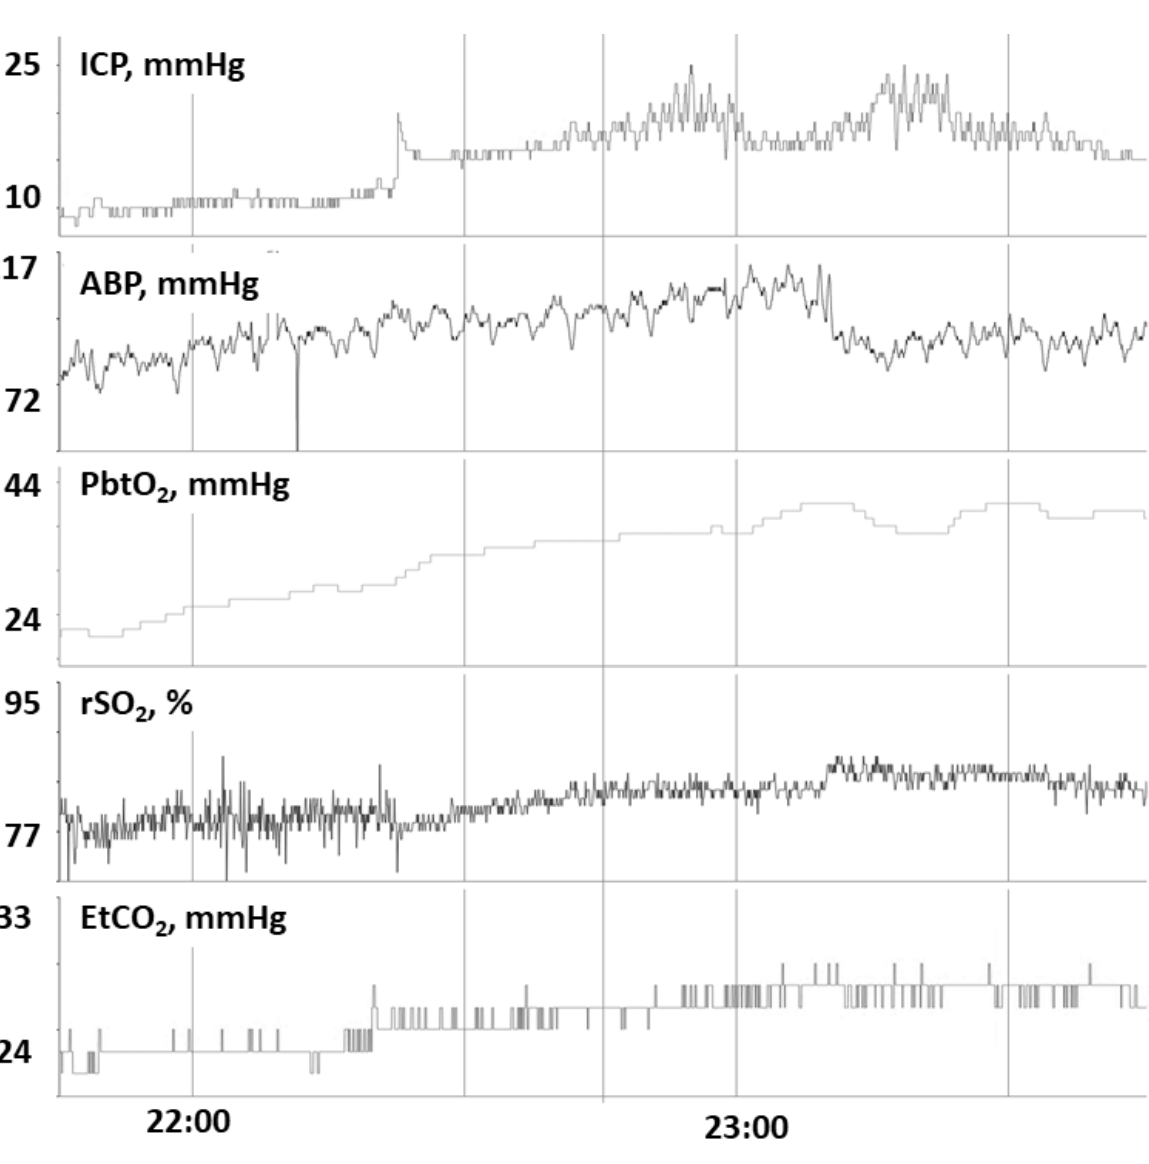
Figure 1. In patient 6, we observe that a rise in EtCO 2 corresponds with a concordant rise in PbtO 2 , rSO 2 and ICP, consistent with intact CO 2 reactivity to PbtO 2 . Abbreviations: ICP, intracranial pres- sure; ABP, arterial blood pressure; PbtO 2 , partial pressure of brain tissue oxygenation; rSO 2 , cerebral regional somatic oximetry; EtO 2 , end-tidal carbon dioxide; mmHg, millimeters of mercury; %, per- centage.